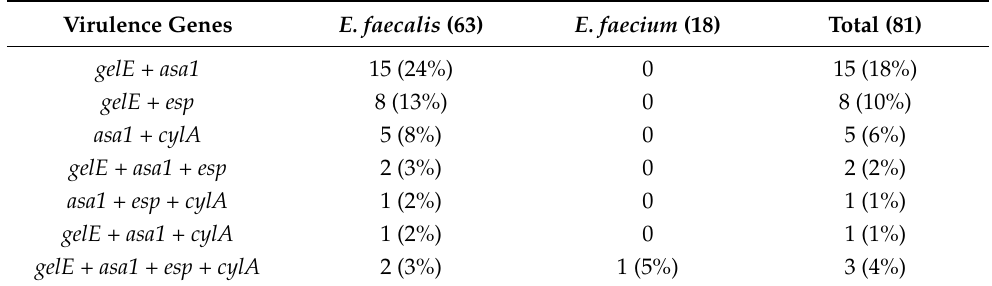
Table 3. Multiple virulence genes patterns in Enterococcus faecalis and Enterococcus faecium isolates. Virulence Genes